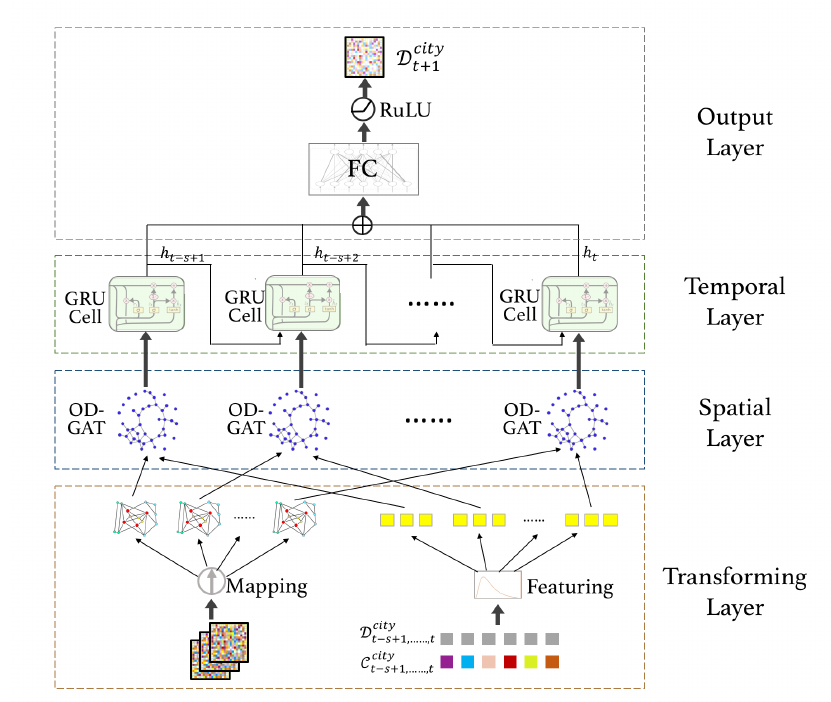
Figure 5. The Origin–Destination-based Temporal Graph Attention Network